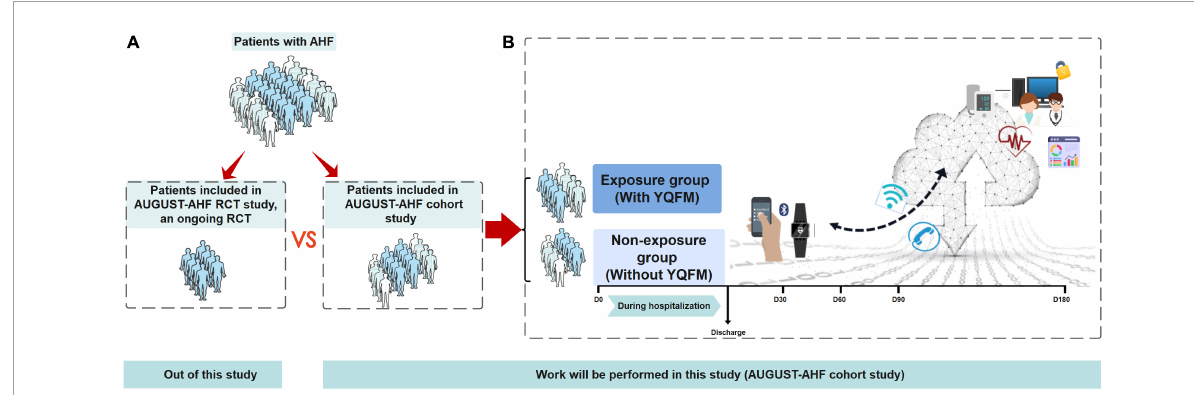
FIGURE1 Overview of study objectives and flow diagram of AUGUST-AHF cohort study. (A) Out of this study. Of the total population of AHF people with yiqi fumai lyophilized injection (YQFM), only a subset are included in randomized controlled trials (RCT), based on the RCT inclusion/exclusion criteria. For this study, the specific RCT of interest is the AUGUST-AHF RCT study, an ongoing RCT which also performed by our team, evaluating the efficacy of YQFM on long-term prognosis. The RCT generates results that inform clinical practice, and the anonymized raw data for the study will be made available to us. (B) Work will be performed in this study (AUGUST-AHF cohort study). This cohort study will comprise patients with AHF, and they will be divided into unexposed and exposed groups according to whether are taking YQFM in real clinical practice. The primary outcome will be a composite of 90-day all-cause mortality or readmission for heart failure, which is the same as AUGUST-AHF RCT study. During 180- day follow-up, we will provide patients with smart watches to monitor their body weight, blood pressure, and heart rate. Smartphone-based clinical reporting applications will also be used to manage patients. Objective 1: thorough our cohort study, assess the effectiveness of YQFM on the 90-day mortality or readmission rate in patients with AHF in real-world setting. Objective 2 compare the result of our study with AUGUST-AHF RCT study. Objective 3 determine the representativeness of the AUGUST-AHF RCT study populations to real-world patients, and describe differences in the characteristics of patients who met the RCT eligibility and those not in AUGUST-AHF cohort study. AHF, acute heart failure; YQFM, yiqi fumai lyophilized injection; RCT, randomized controlled